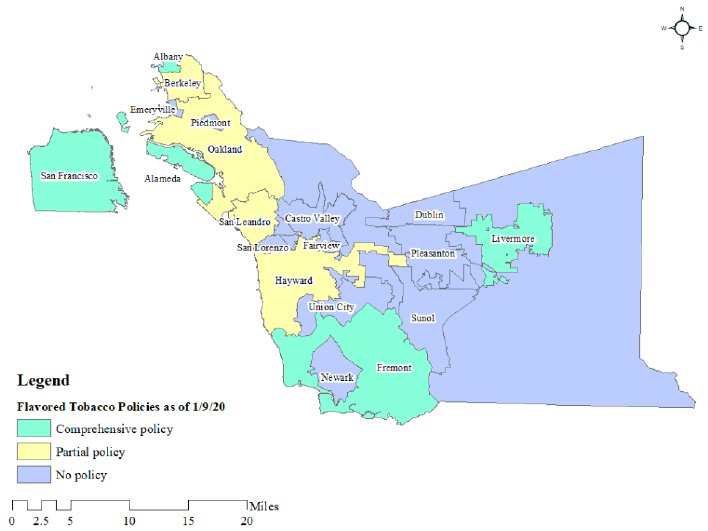
Figure 1. Brief Timeline of Tobacco Retail Data Collection Periods and Relevant Flavored Tobacco Policy Changes.